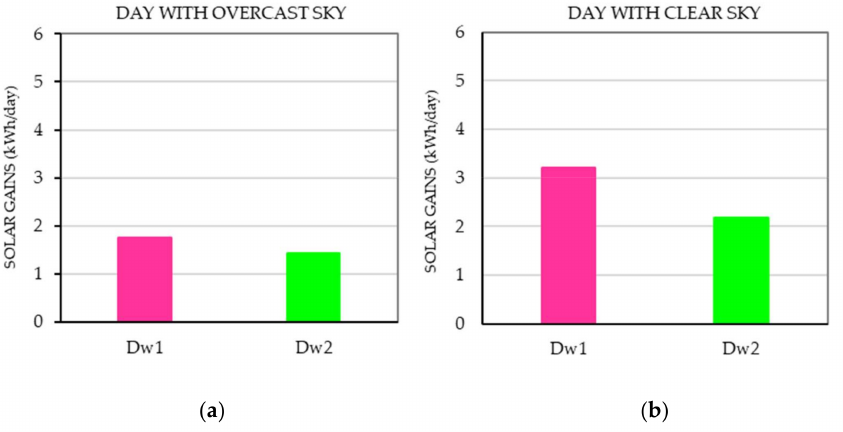
Figure 8. Dw1 (magenta) and Dw2 (green) solar gains by windows, ( a ) overcast day, and ( b ) clear sky